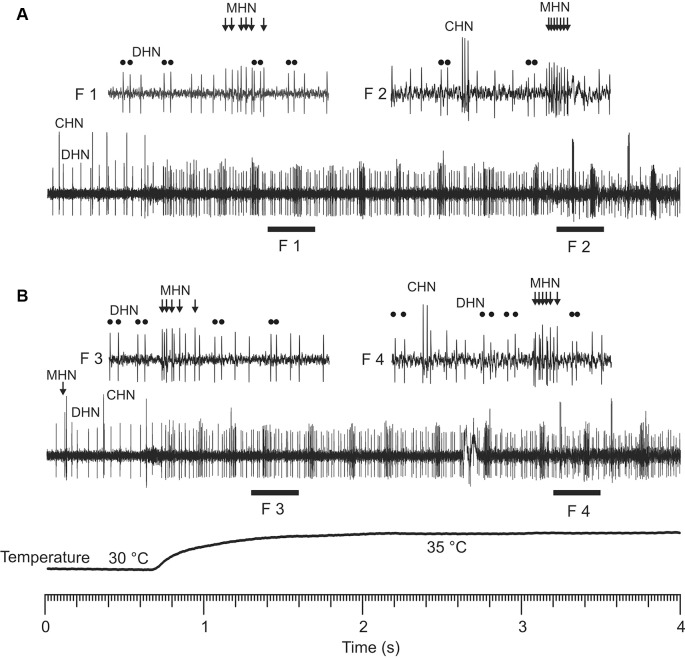
Repeatability of spike burst responses of the DSS neurons in a rapid warming experiment. Note that a particular DSS neuron produced nearly identical bursty spike trains (A,B) in response to the same consecutive warming stimulus. Temporal interval between the two stimulations was 10 min. F1–F4 show fragments of the original recordings (A,B) in a shorter timescale. High-frequency spike bursts of the CHN were shown in the fragments F2 of (A) and F4 of (B), respectively. Double round dots demonstrate bursty spikes of the DHN in the fragments F1–F4, respectively. Bunches of arrows in the fragments F1–F4 indicate bursty spikes generated by the MHN.